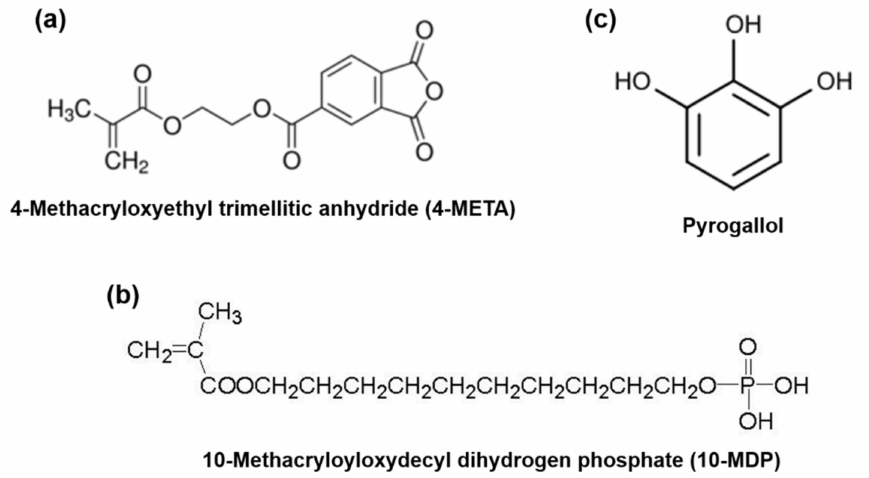
Figure 1. Chemical structure of the acidic monomers used in Iperbond Max and pyrogallol: ( a ) 4- META, ( b ) 10-MDP, and ( c )